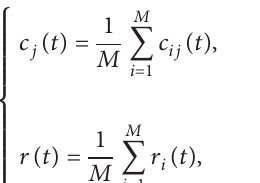
Figure 2: EEMD flow